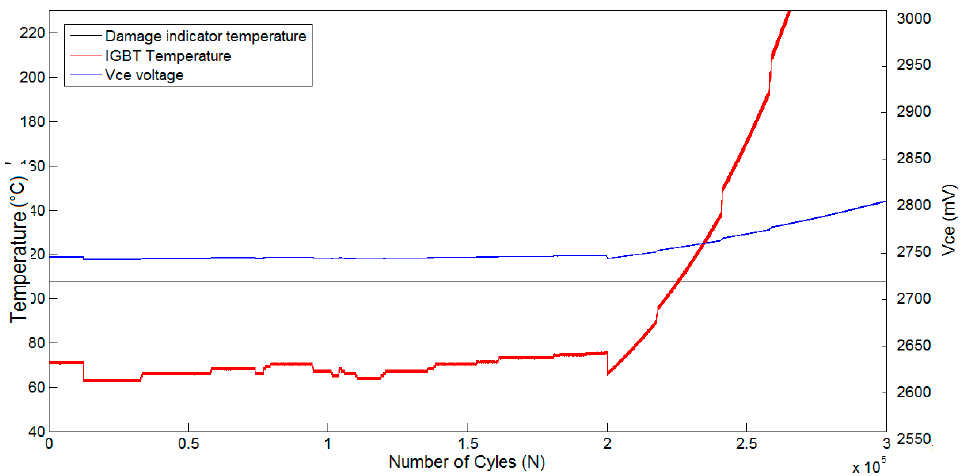
Figure 20. Power cycling test results.